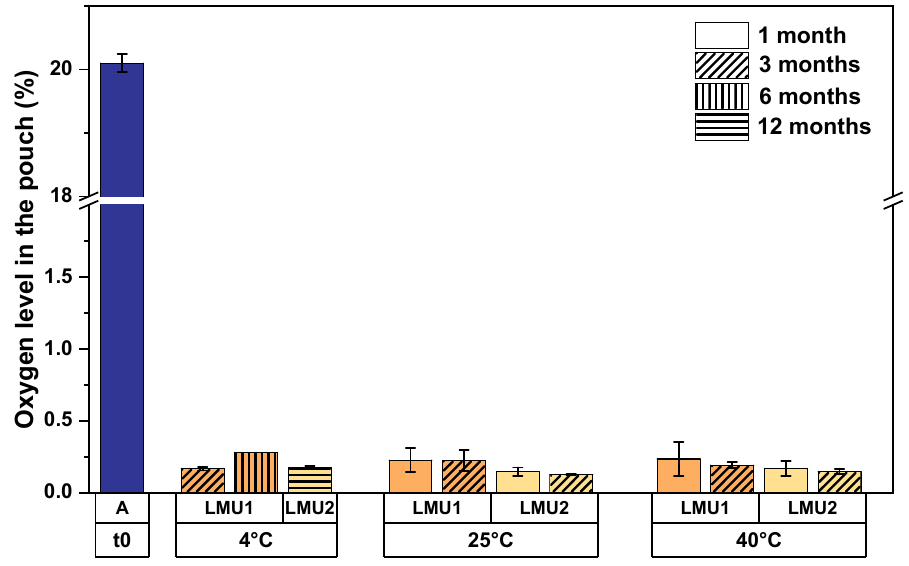
Figure 2. Oxygen levels in the aluminum pouches stored at different temperatures for the respective time. Sealing was done at ambient conditions with a mean oxygen concentration of 20.1% (blue). The bars are means of six individual pouches; the error bars represent the standard deviation. A, ambient.